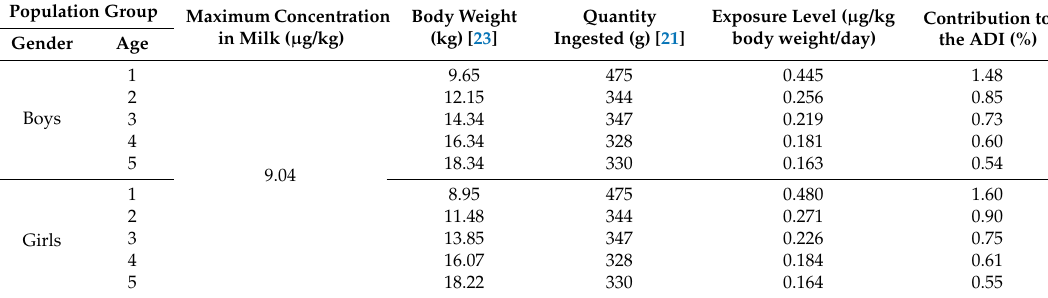
Table 6. Estimated dietary exposure to progesterone in raw milk in children aged between one and five years, using the maximum